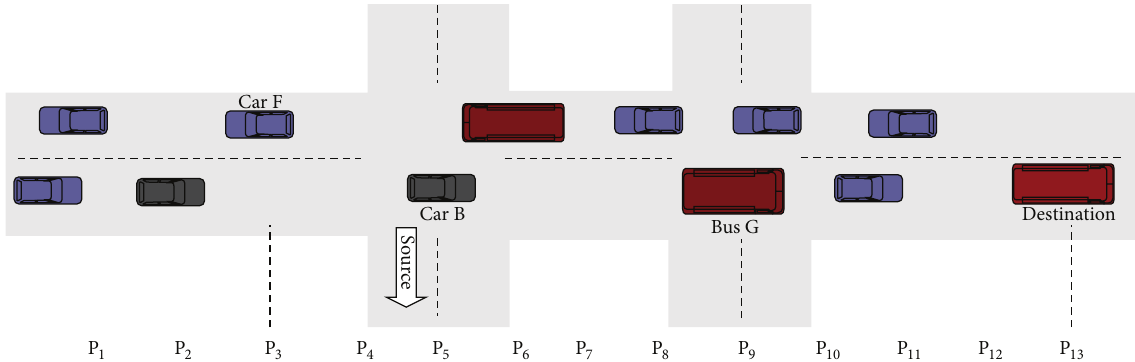
Figure 3: An example illustrating the scenario for time t 2 when any node has left its initial